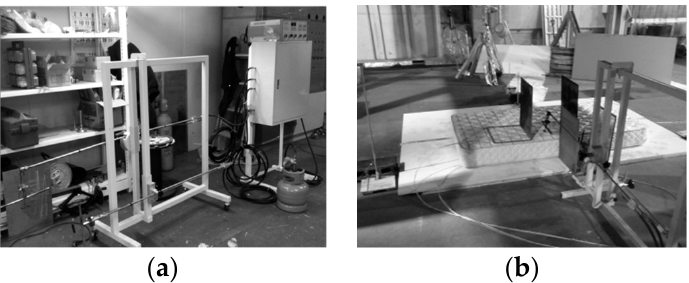
Figure 5. Burner’s status by ISO 12949. ( a ) Shape of burners. ( b ) Configuration of the test facility.